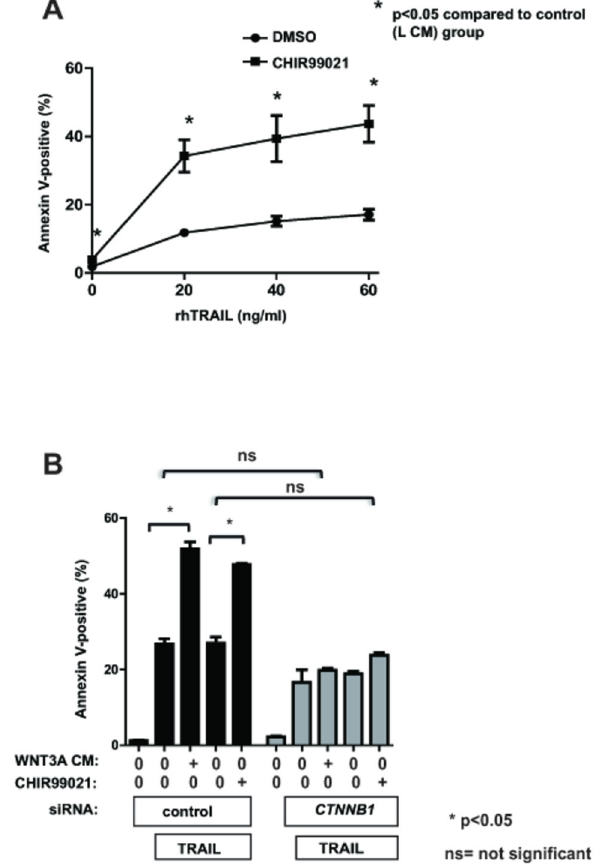
Figure 4. Inhibition of GSK-3 sensitizes melanoma cells to TRAIL-mediated apoptosis. A) A375 melanoma cells were treated with rhTRAIL at doses indicated on x-axis. Cells were concurrently treated with the GSK-3 inhibitor CHIR99021 (5µM) or DMSO vehicle control (v/v). Data represents the percentage of apoptotic cells measured by Annexin V-positive cells at 24 hours post-treatment by FACS. B) A375 cells were pre-treated with control siRNA or siRNA specific for β-catenin. 48 hours later, cells were treated with rhTRAIL (20ng/mL). 24 hours post-treatment, the percentage of apoptotic cells was determined by AnnexinV binding using FACS. Data represents mean percentage of apoptotic cells (+/- SEM). P-values were calculated by one-way ANOVA with a Tukey’s post-test siRNA-mediated knockdown significantly sensitized multiple melanoma cell lines to apoptosis when treated with a targeted small molecule inhibitor of oncogenic BRAF [18]. To determine the effect of AXIN1 depletion on TRAIL-mediated apoptosis, we pre-treated melanoma cell lines with siRNA specific for AXIN1 prior to treatment with TRAIL and WNT3A CM. We targeted two cell lines, COLO829 and SKMEL28, which exhibited no significant apoptosis with TRAIL plus WNT3A (Figure 2). AXIN1-depleted cells were significantly more sensitive to